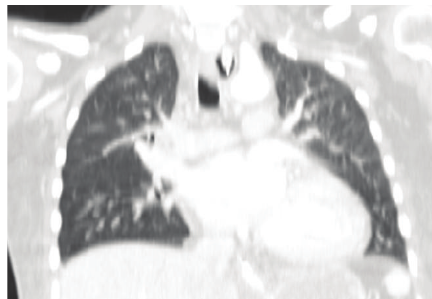
Figure 3: CT thorax four months after treatment demonstrates improvement in airspace